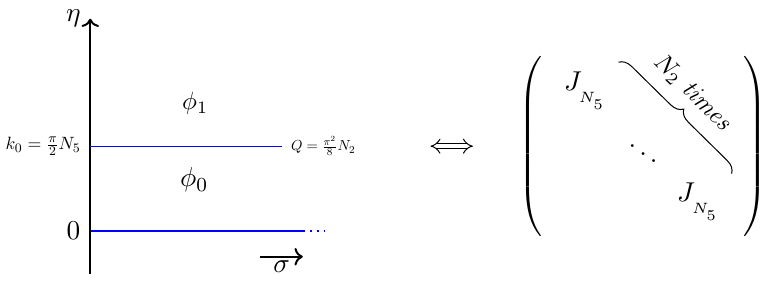
Figure 2 . Electrostatic problem associated to N 2 copies of N 5 -dimensional